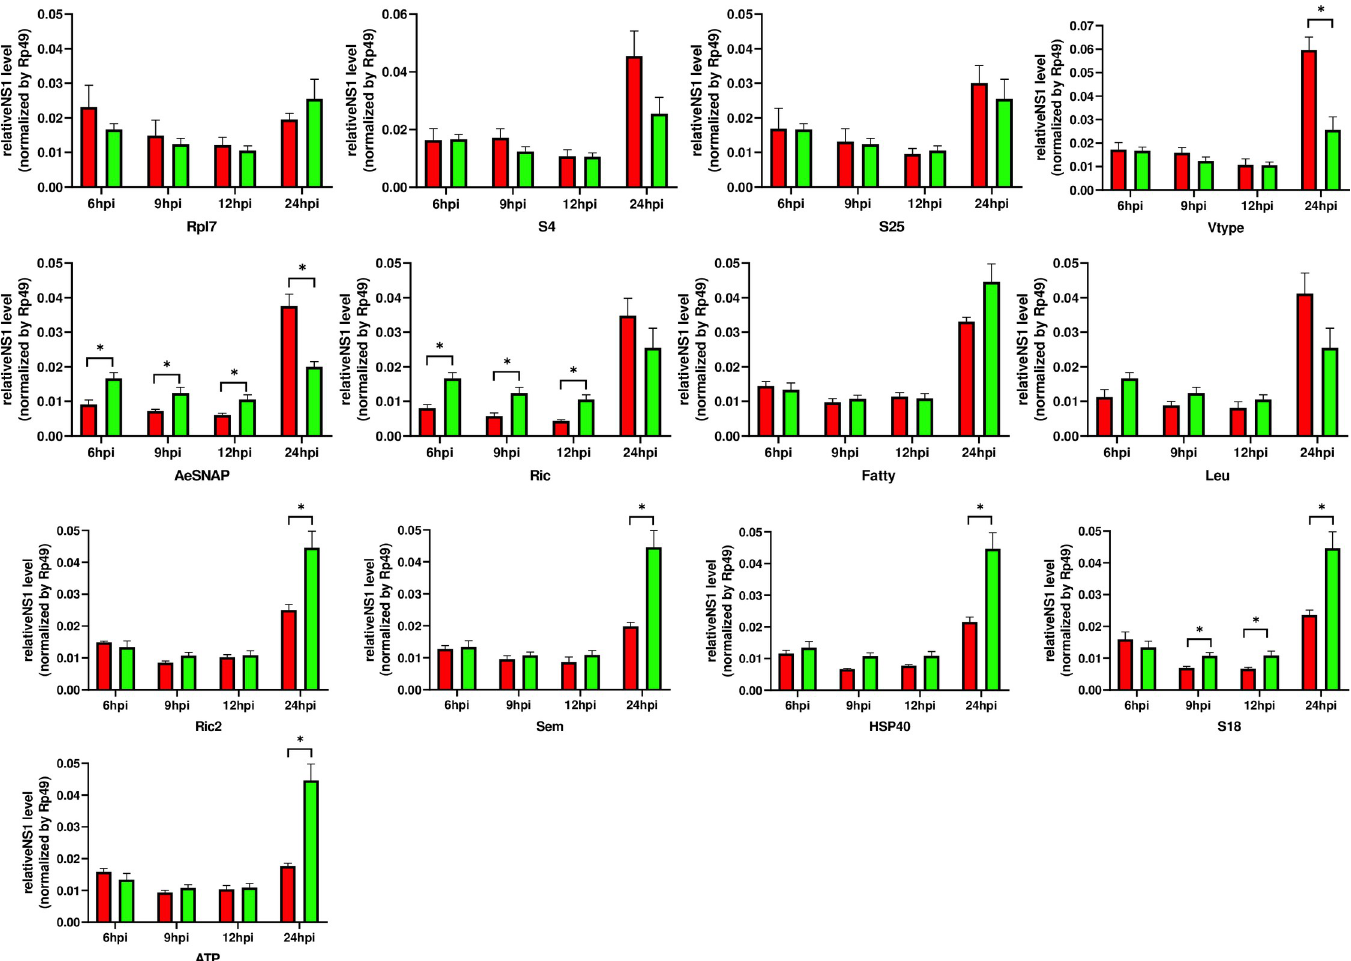
Fig 3. DENV infection relative levels in Aag2 cells. Viral burden was analyzed in Aag2 cells infected with DENV2 (MOI of 1.0) and was measured using qRT-PCR analysis at the timepoints indicated. Samples were taken at 6, 9, 12 and 24h post-knockdown to see the effect of silencing during DENV2 infection. The results represent the averages from samples done in pentaplicate, with the mean and standard deviation. In green, GFP-silenced control cells. In red, protein-silenced cells. Asterisks represent significant difference between samples, calculated by the Mann-Whitney nonparametric test (P <